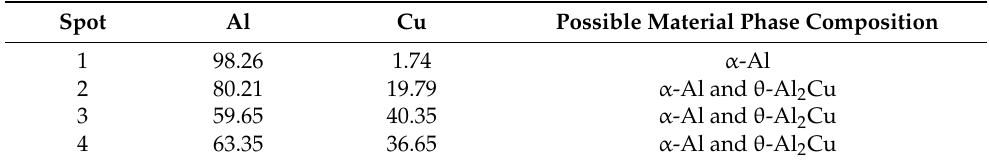
Figure 7. Microstructure and EDS composition analysis of B 4 C-free powdered aluminum alloy deposited parts ( a ) SEM analysis, ( b – e ) EDS analysis. Table 3. The EDS analysis results for each point in Figure